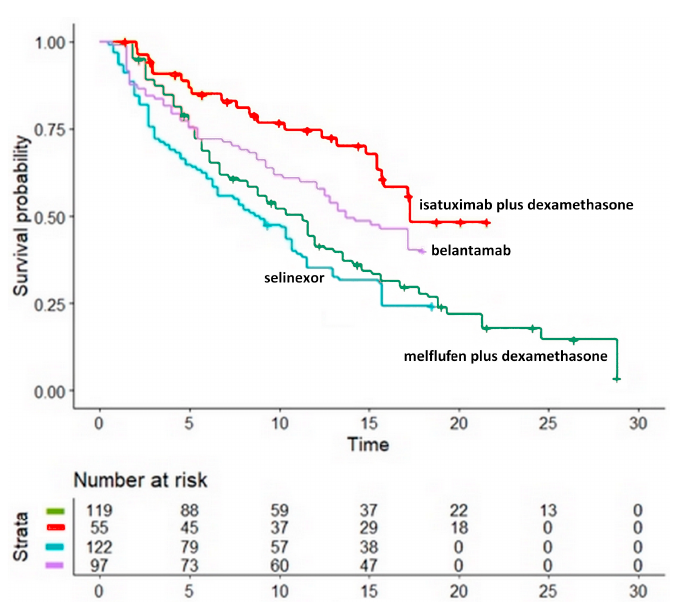
Figure 2. Kaplan-Meier curves from reconstructed patient-level data. These four survival curves were obtained by reconstruction of individual patient data from four trials: melflufen